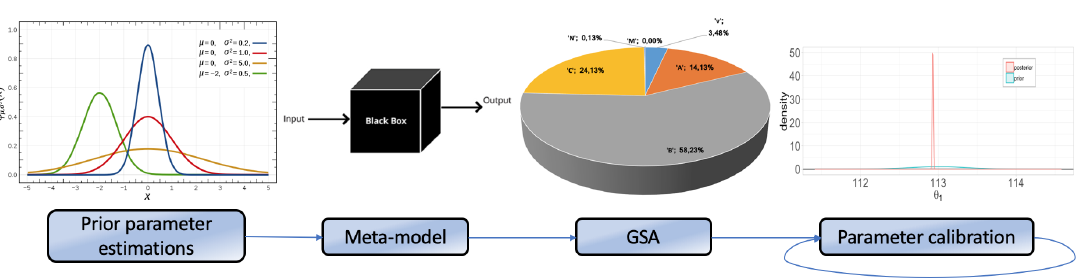
Figure 3. Iterative process for a two-stage approach of screening and calibration of model